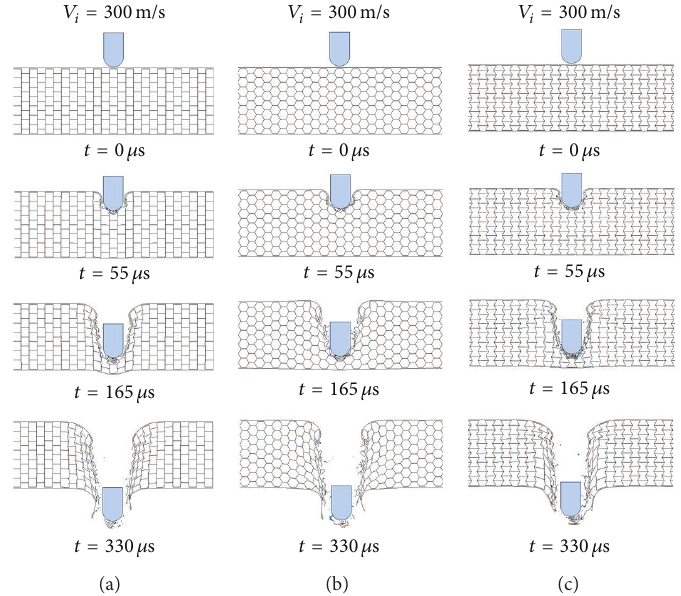
Figure 12: Perforation processes of (a) R-type, (b) H-type, and (c) A-type HSPs by the projectile at 𝑉 𝑖 = 300 m/s.